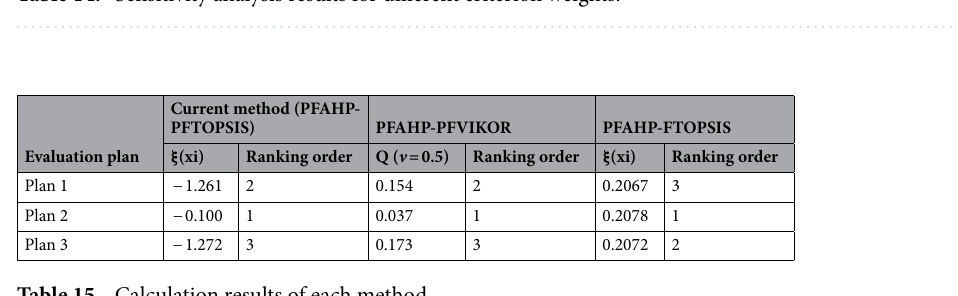
Table 14. Sensitivity analysis results for different criterion weights.